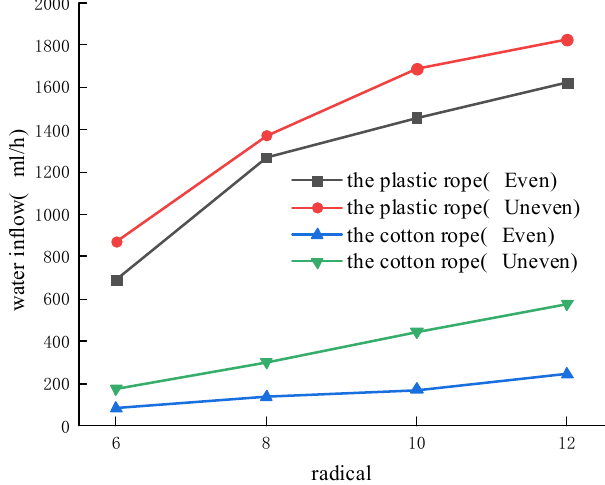
Figure 17. A seepage effect diagram of the plastic/cotton rope fiber bundle. Table 6. The seepage flow of drainage pipes of different fiber bundles.